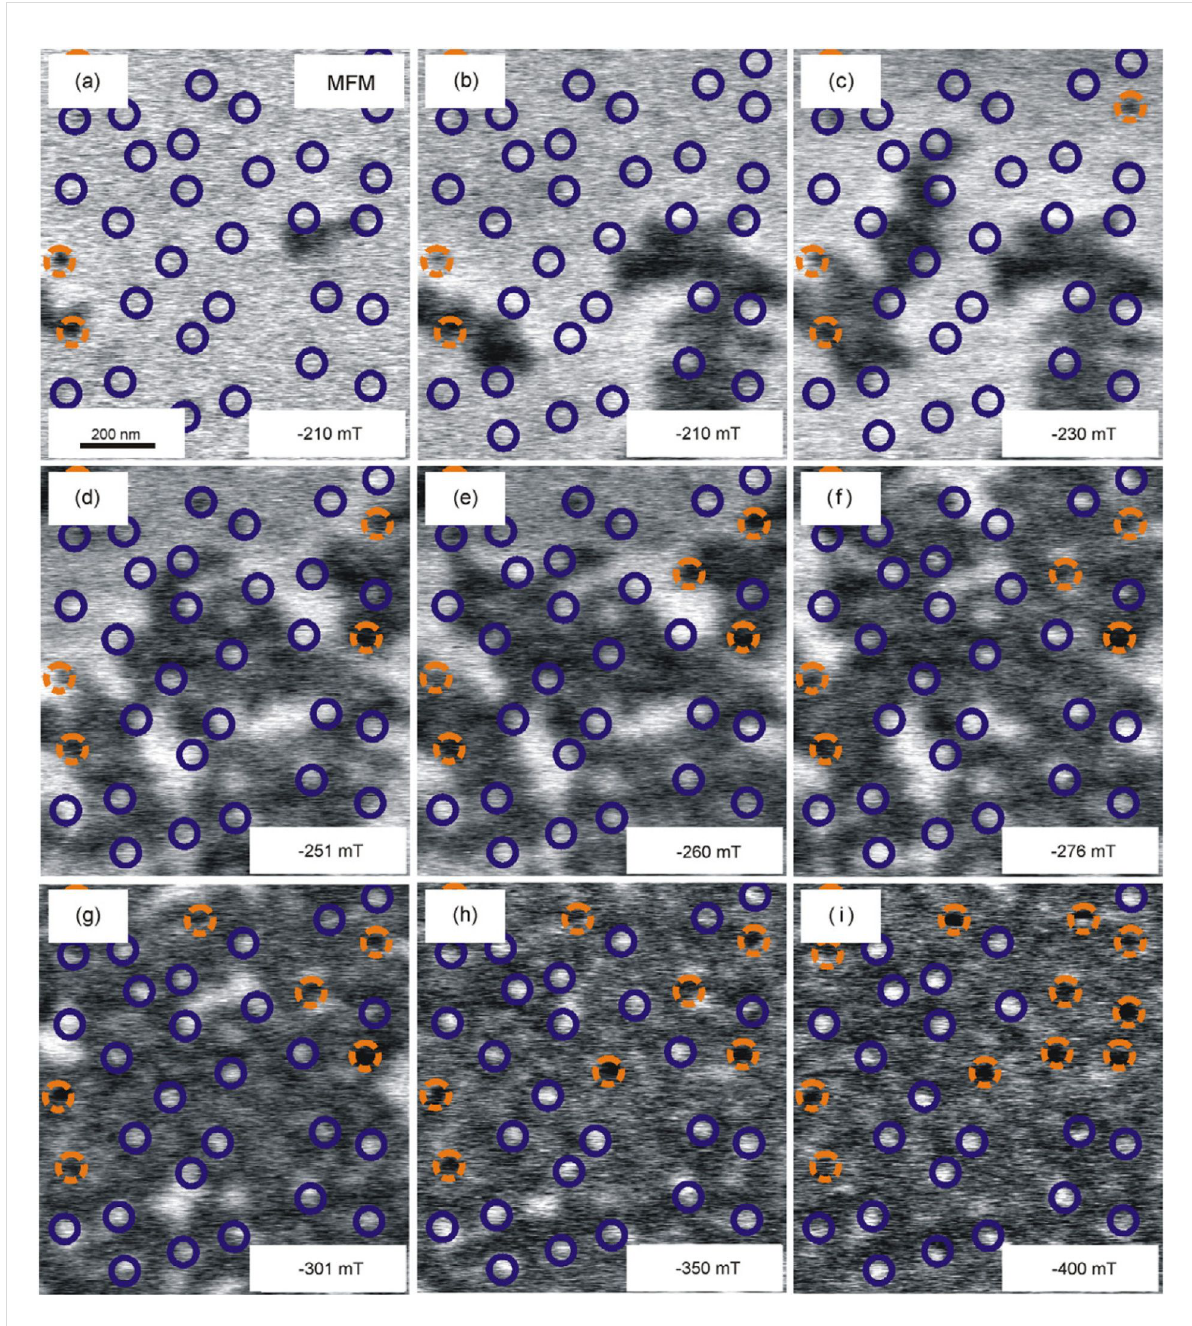
Figure 7: (a–i) MFM images of the same spot taken in different perpendicular fields after driving the sample to the positive saturated state at +1.6 T. Switched magnetic caps are indicated by dashed orange circles, while purple circles mark the unaffected caps. Panels (a) and (b) are two scans at identical field showing the growth of nucleated domains in the direction of the external field. This process is either thermally activated or induced by the tip. The figure has been reproduced with permission from [25] – Copyright 2009 Institute of Physics.